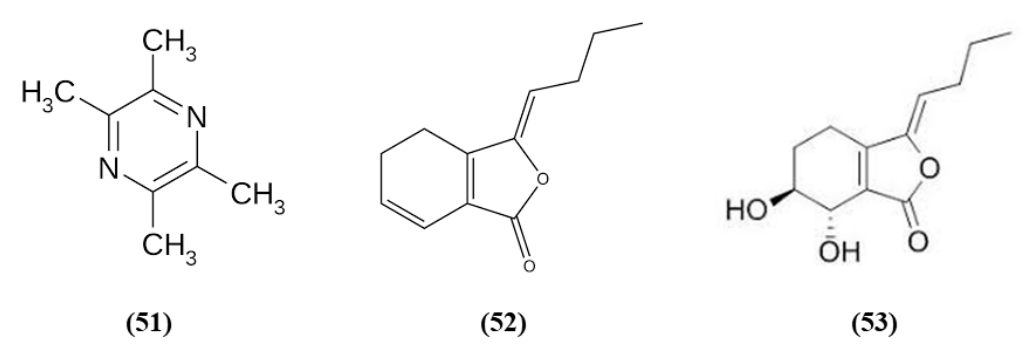
Figure 10. Chemical structure of ( 51 ) tetramethylpyrazine, ( 52 ) Z-ligustilide, and ( 53 ) senkyunolide